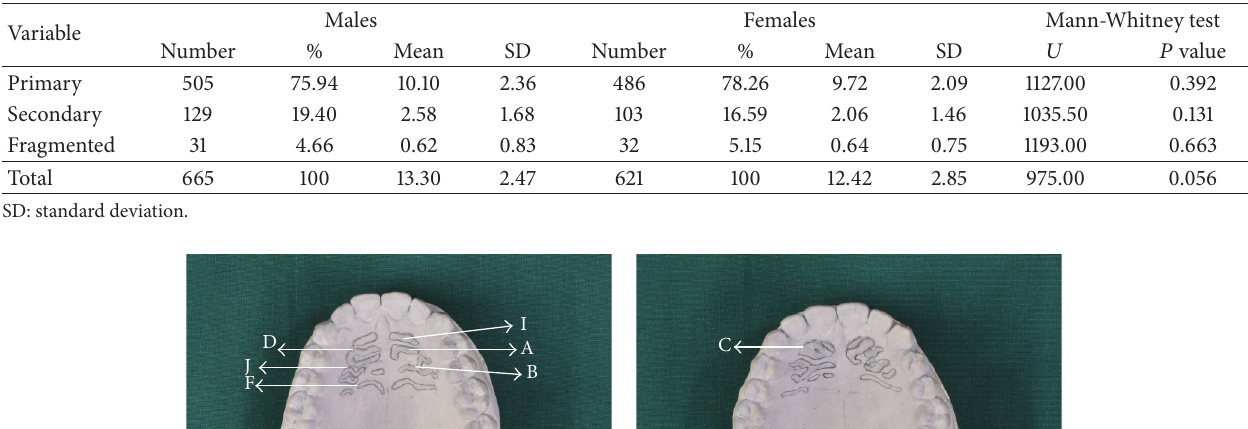
Table 1: Descriptive statistics for palatal rugae lengths in both sexes.